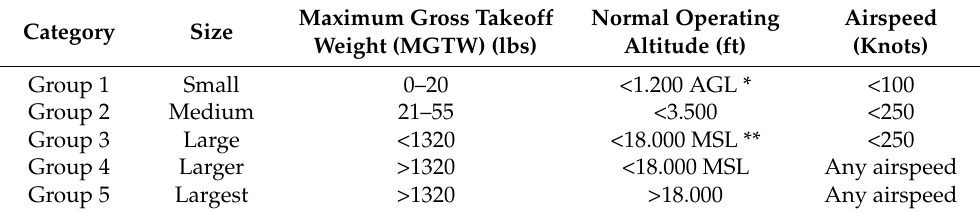
Table 1. UAVs Classification according to the US Department of Defense (DoD) [13].